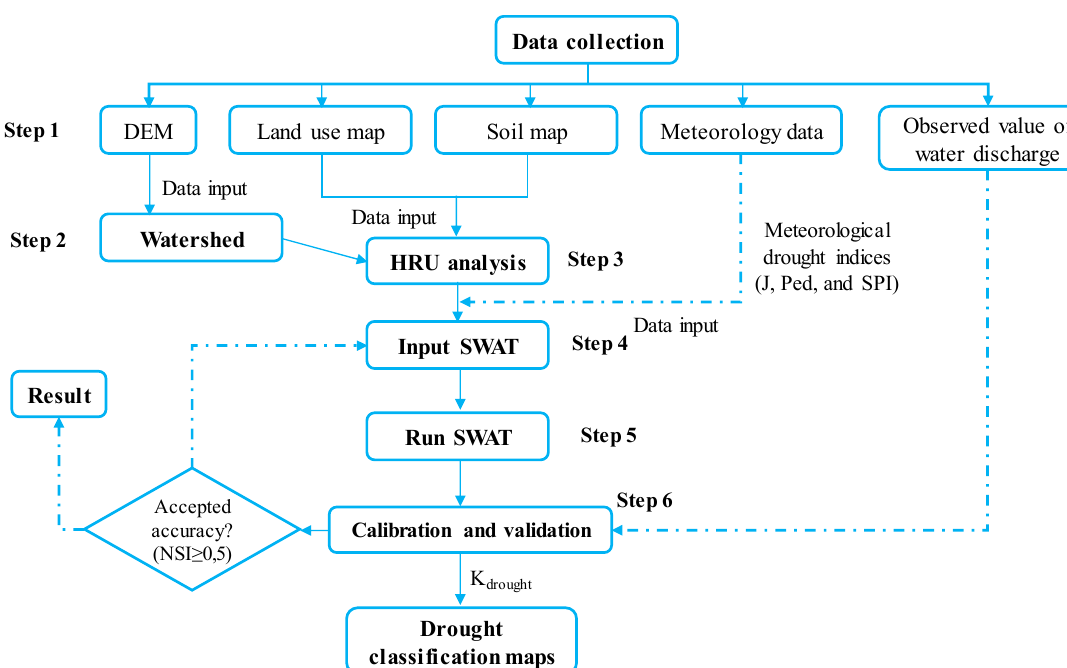
Figure 1. The flow diagram of the methodology.